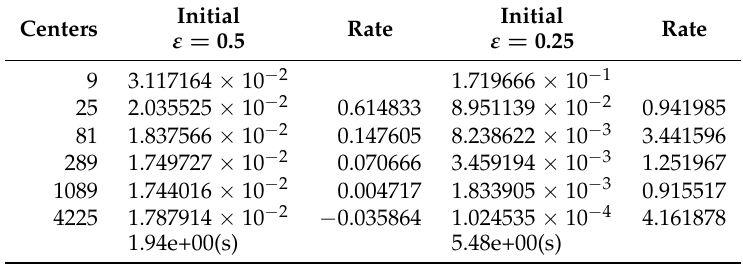
Figure 5. Final error graphs on level 6. Top left to bottom right: ε = 0.5, 0.25, 0.125, and 0.0625. Table 11. H-RBFs collocation of example 2: with initial 0.5 and 0.25.